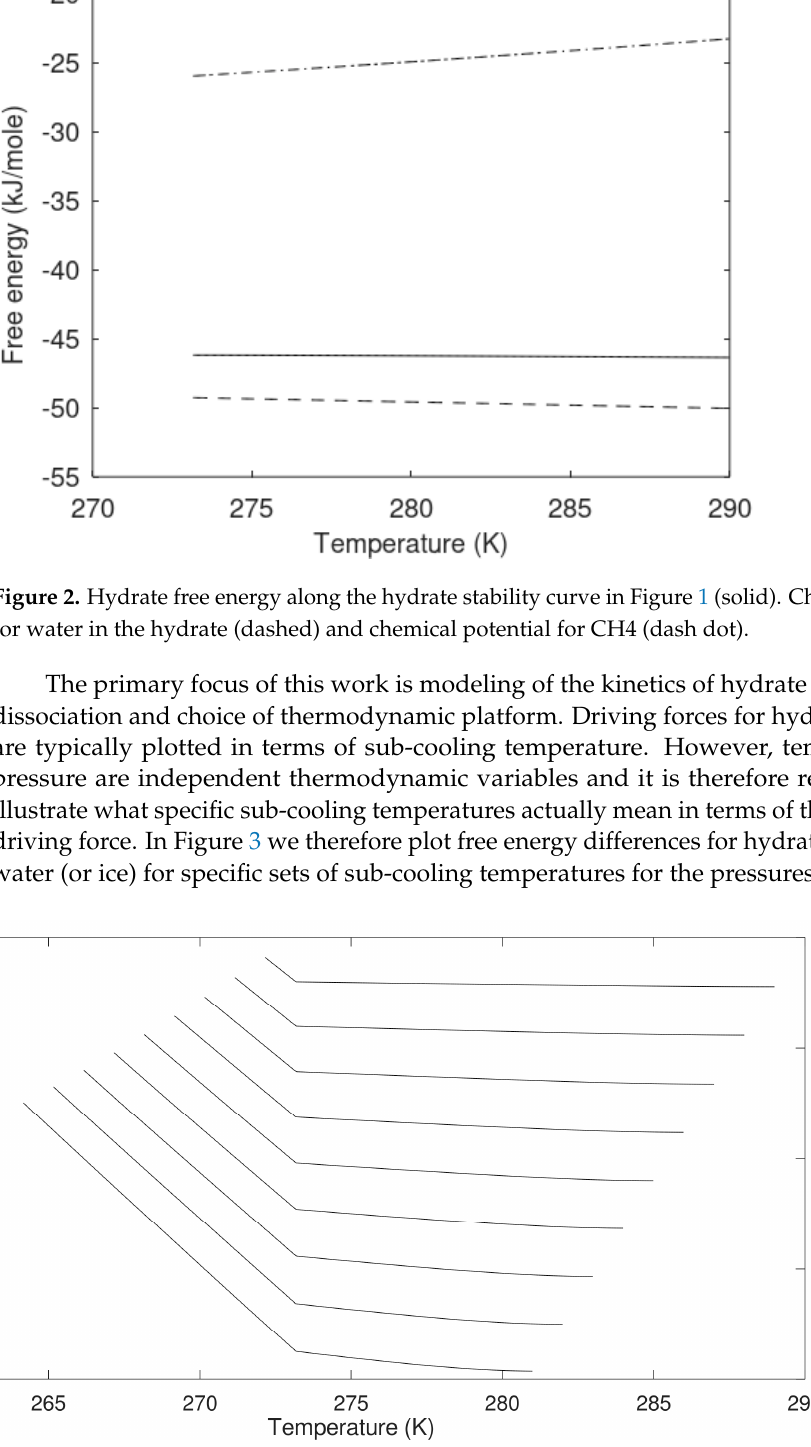
Figure 1. Pressure and temperature hydrate stability limits from calculations (solid curve) and two